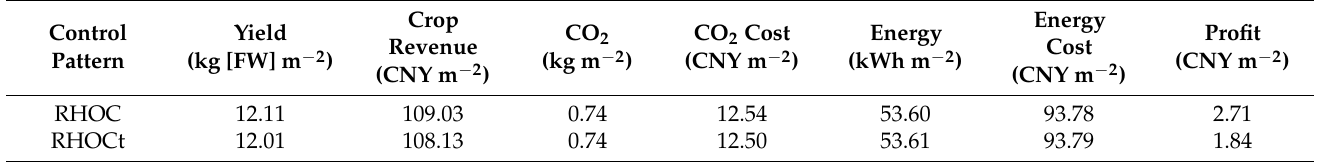
Table 4. Numbers in closed-loop simulations without and with the computation